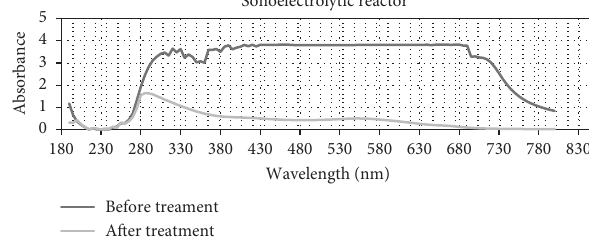
Figure 8: Plot of absorbance with respect to wavelength over 830nm. It shows a change in parameters of wastewater (before and after